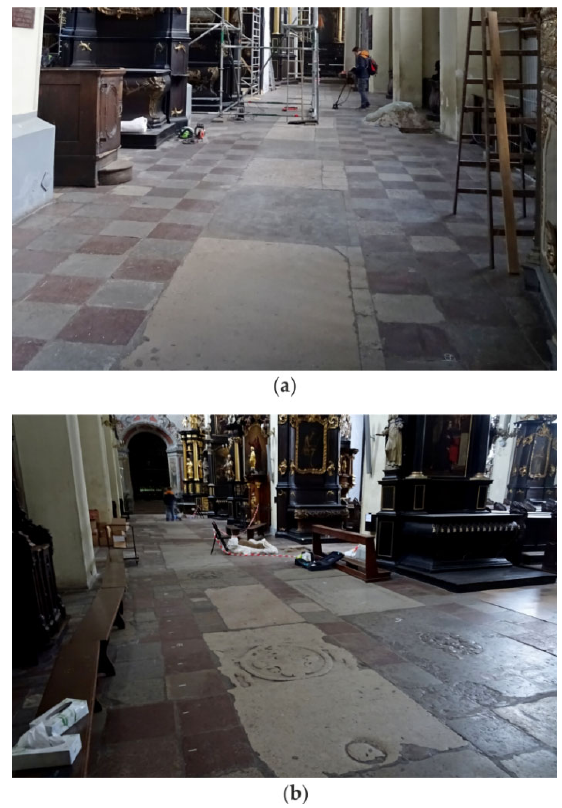
Figure 1. Photograph of the floor in St. Nicholas’ Church in Gda ń sk, Poland (Google Maps coordinates in a WGS84 system: 54.352206 N, 18.651510 E): ( a ) south aisle; ( b ) north